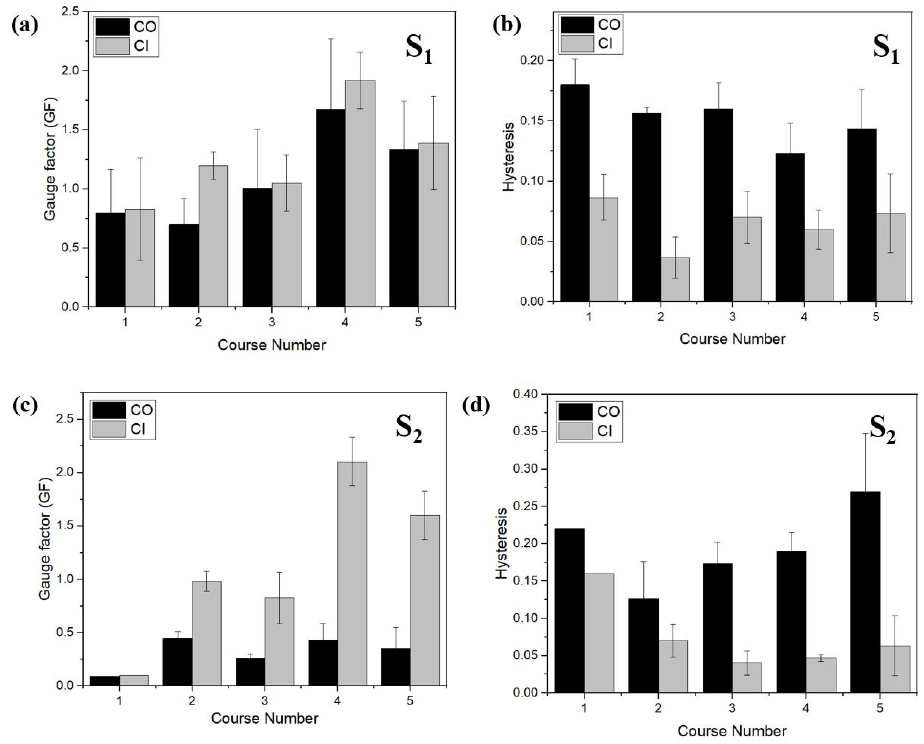
Figure 11. Effect of course number and yarn position S 1 yarn and S 2 yarn, respectively; ( a ) Gauge factor vs course number, ( b ) Hysteresis vs course number, ( c ) Gauge factor vs course number, and ( d ) Hysteresis vs course number.